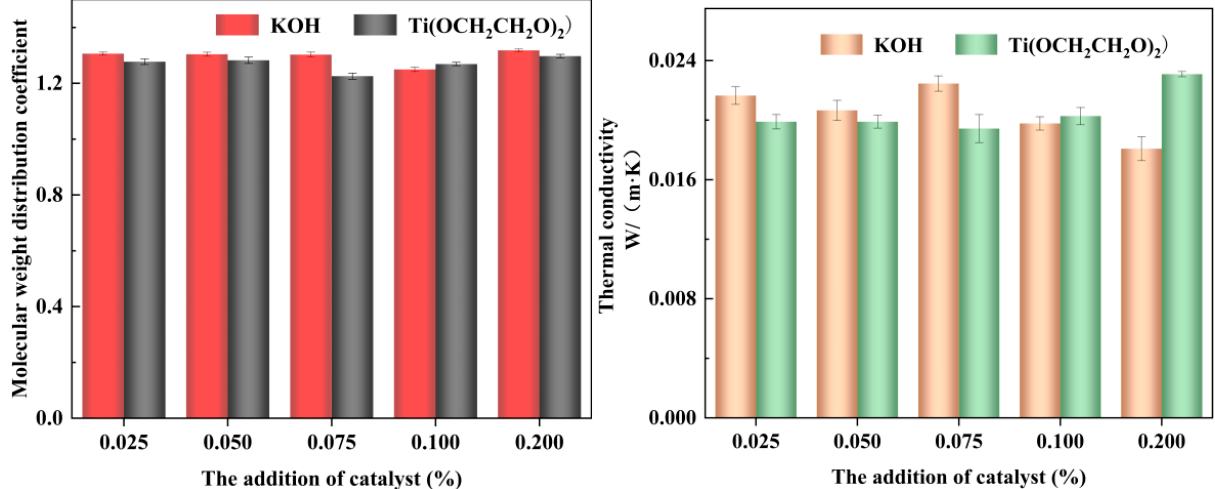
Figure 12. Determination of the molecular weight distribution coefficient of the regenerated polyether polyol and the thermal conductivity of the regenerated polyurethane foam under different catalytic systems.